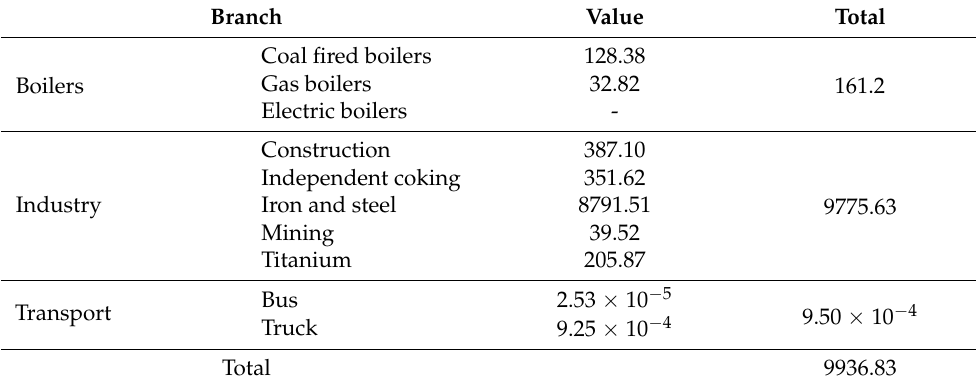
Table 4. Carbon emission values by sector in Panzhihua (Base Year).